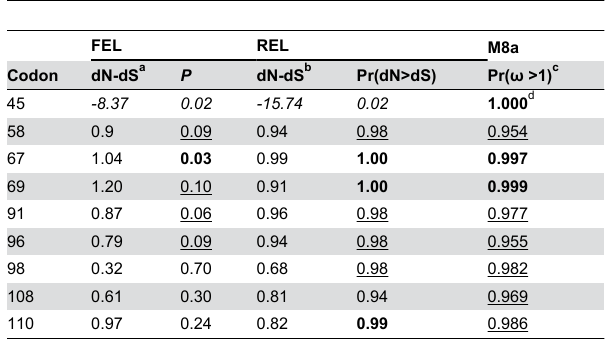
Figure S1. Maximum likelihood genealogy of the effector gene family in Figure 4 showing allelic variation in P.